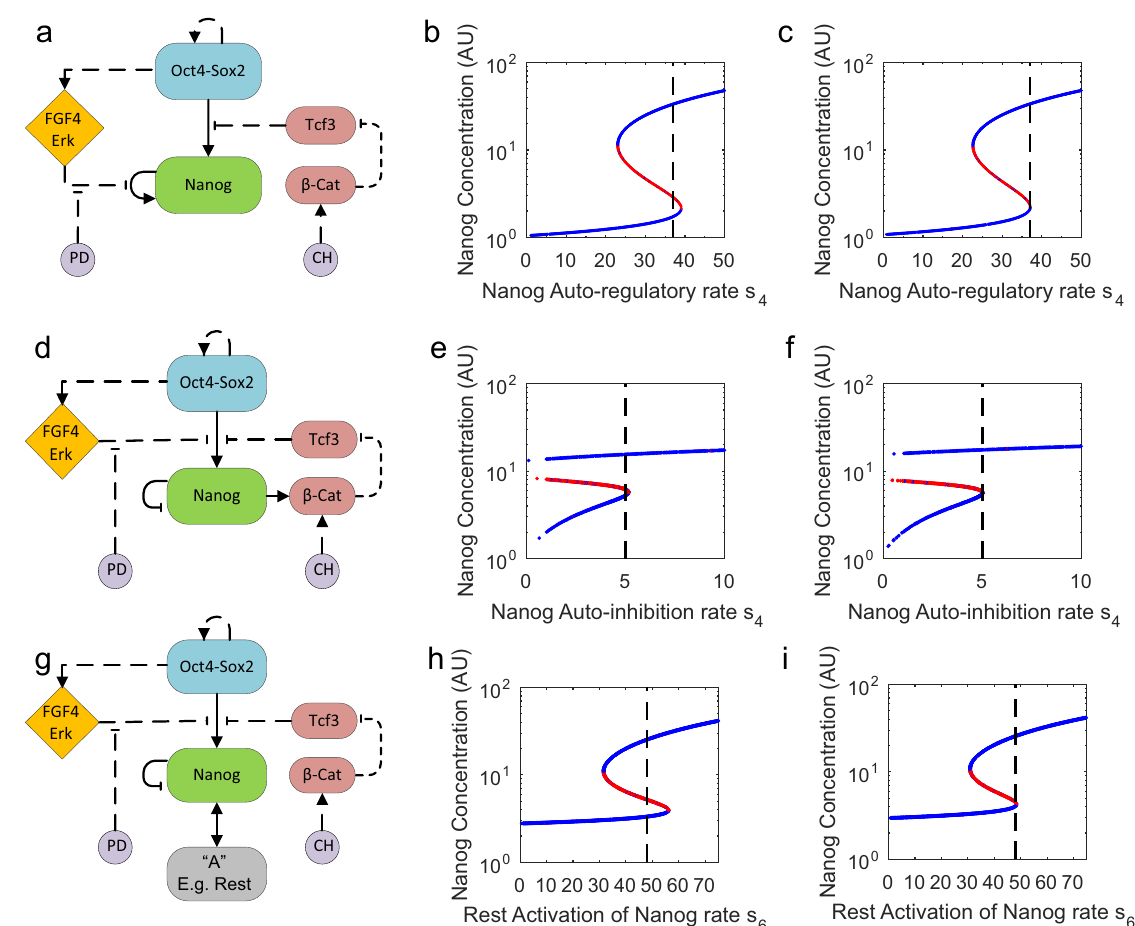
Fig. 5 Simpler network models demonstrating bistability of Nanog. a Scheme of simpli fi ed network, composed of core factors Nanog, Oct4, Sox2; Fgf4/Erk, β -catenin and Tcf3 are added to account for the inputs (i.e., PD and Chiron (CH), the two inhibitors present in 2i/LIF). Solid and dashed lines indicate transcriptional and non-transcriptional interactions, respectively. b , c Continuation of Nanog steady-state for the deterministic system (no noise) in serum/LIF ( b ) and 2i/LIF ( c ). Blue lines are stable steady states, while red lines are unstable. The maximal transcription rate, s 4 ( dotted black line ), intersects both NH and NL steady-states, indicating bistability in serum/LIF ( b ), but is close to the saddle-node bifurcation in 2i/LIF ( c ). d Scheme of Nanog auto-inhibitory simpli fi ed network, with additional activation of β -catenin by Nanog. e , f Continuation of Nanog steady-state for the deterministic system (no noise) in serum/LIF ( e ) and 2i/LIF ( f ). Blue lines are stable steady-states, while red lines are unstable. The maximal transcription rate of Nanog auto-inhibition, s 4 ( dotted black line ), intersects both NH and NL steady- states, indicating bistability in serum/LIF ( e ), while being closer to the saddle-node bifurcation in 2i/LIF ( f ). g Scheme of Nanog auto-inhibitory simpli fi ed network, with additional positive feedback supplied via an extra factor, i.e. Rest. h , i Continuation of Nanog steady-state for the deterministic system (no noise) in serum/LIF ( h ) and 2i/LIF ( i ). Blue lines are stable steady-states, while red lines are unstable. The maximal transcription rate of Rest activation on Nanog, s 6 ( dotted black line ), intersects both NH and NL steady-states, indicating bistability, in serum/LIF ( h ), and is very close to the saddle-node bifurcation in 2i/LIF ( i